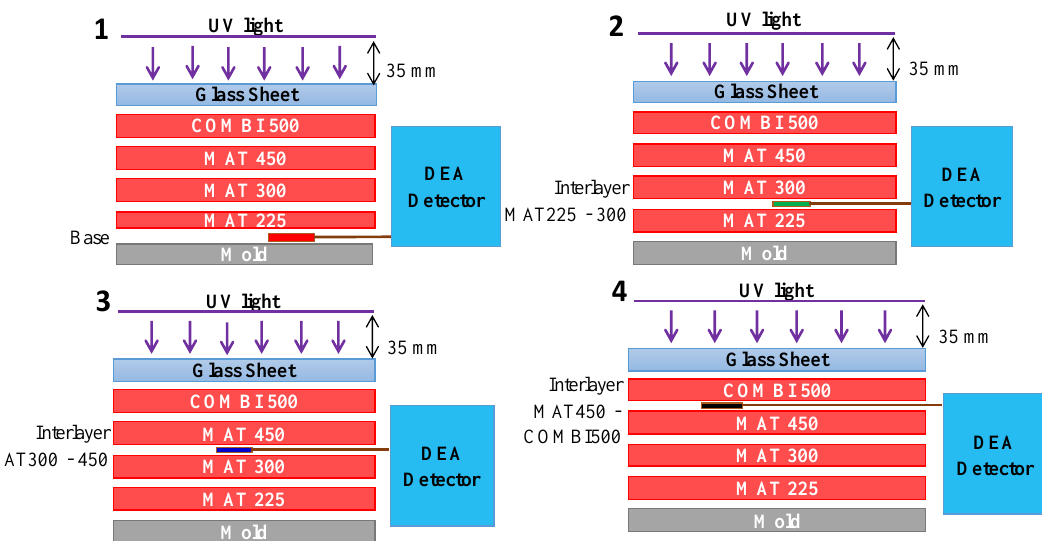
Figure 5. Schematic representation of the composite set-up interlayer curing degree measurement.